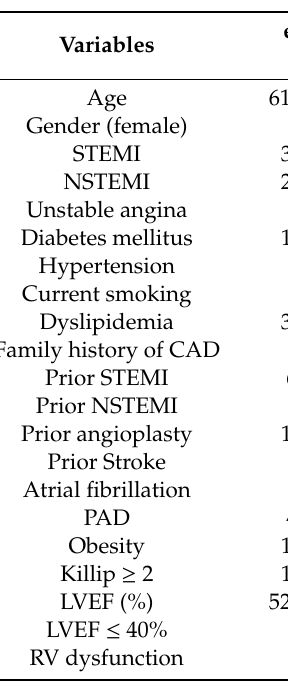
Table 1. Baseline demographic and clinical characteristics according to renal